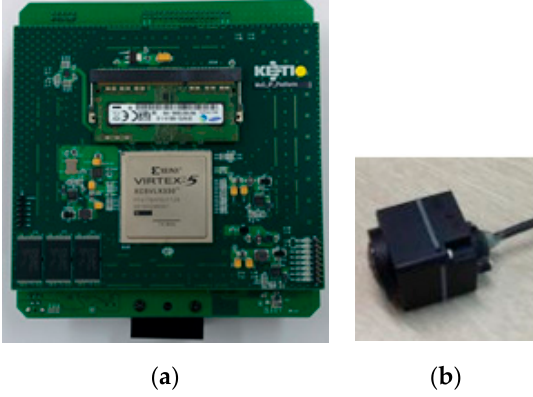
Figure 6. The FPGA platform with camera. The ( a ) platform takes LVDS signal from ( b ) camera and outputs as HDMI signal. External HDMI recorder was needed for further analysis as the platform processes the input frames on-the-fly.